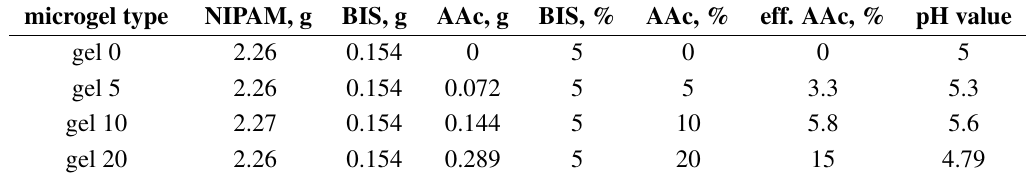
Table 1. Characteristics of the synthesized microgels. In the first column the names of